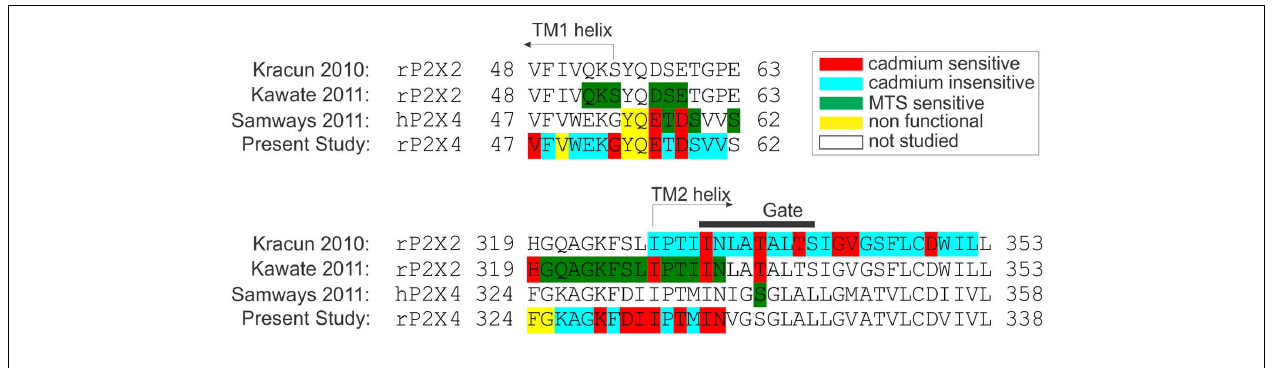
FIGURE 7 |Amino acid sequence alignment of P2XRs used in studies for probing surface accessibility ofTM and ectodomain residue side chains in channels in an open state. The alignment represents the comparison of amino acid side chain modifications with cysteine modifying MTS agents (Kawate etal., 2011; Samways etal., 2011) or cadmium (Kracun